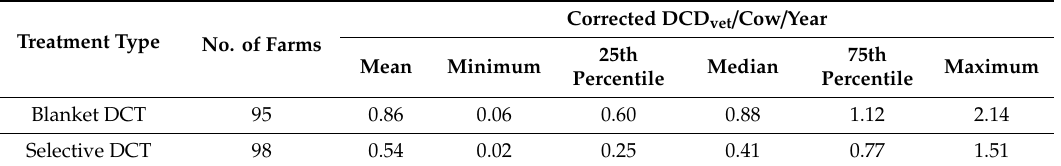
Table 1. Antimicrobial dry cow therapy by treatment type, based on antimicrobial data from veterinary practice software (n = 193). DCT = dry cow therapy, DCD vet = Defined Course Dose